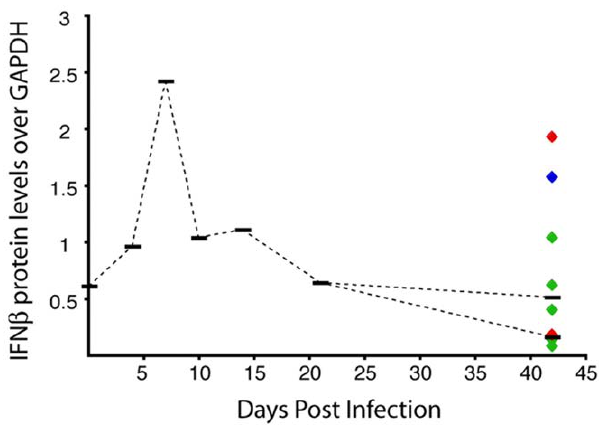
Figure 4. IFN b protein levels in brain of SIV-infected macaques. Brain homogenates were made from brain from uninfected and SIV- infected macaques at terminal time points (4, 7, 10, 14, 21, or 42 days after inoculation) and IFN b protein was quantitated by quantitative western analyses as described in Methods and Materials. Medians (black bars) for each experimental group are indicated. For the 42 day group, each diamond represents one animal, color-coded according to CNS disease severity (red-severe; blue-moderate; turquoise-mild; green- none), and the black bars represent the medians for severe/moderate (red dotted line), and mild/none animals (green dotted line). Protein band intensities were normalized to GAPDH.